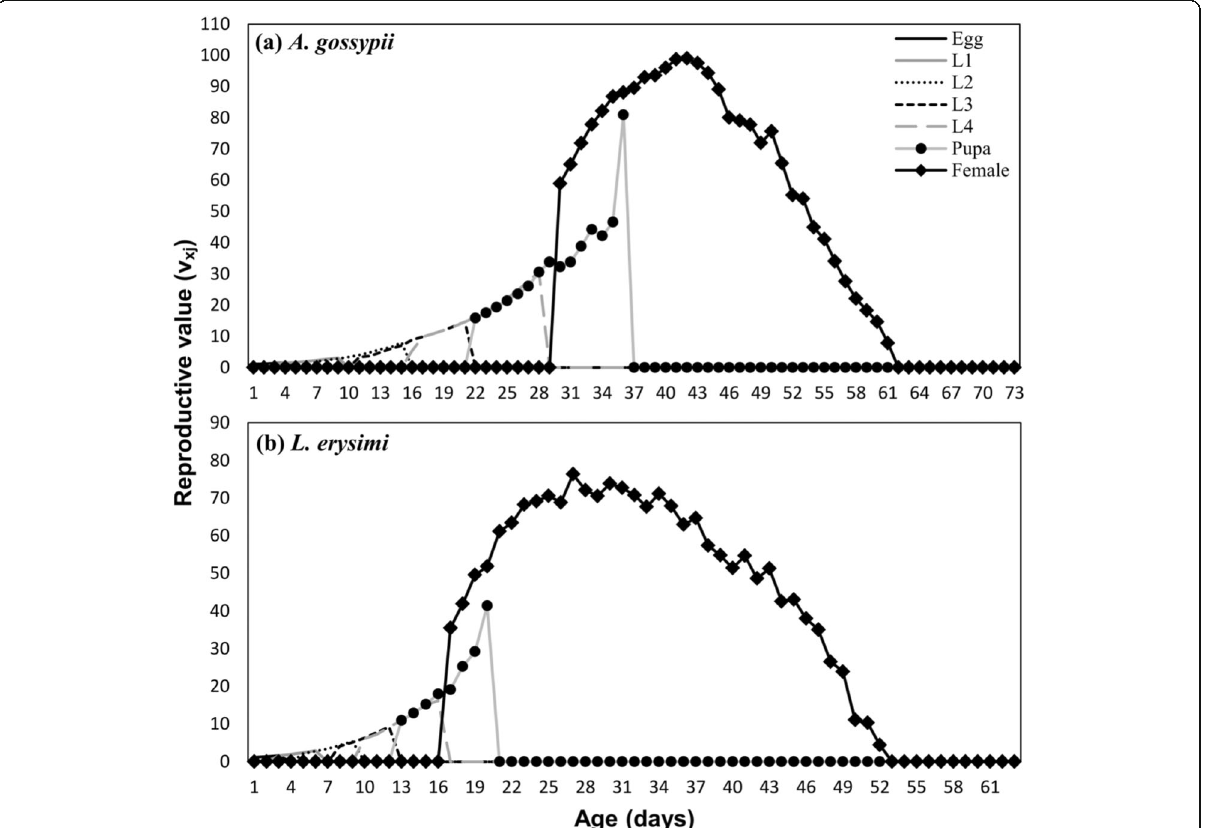
Fig. 4 Age-stage-specific reproductive rate ( V xj ) of Hippodamia convergens fed on two aphid